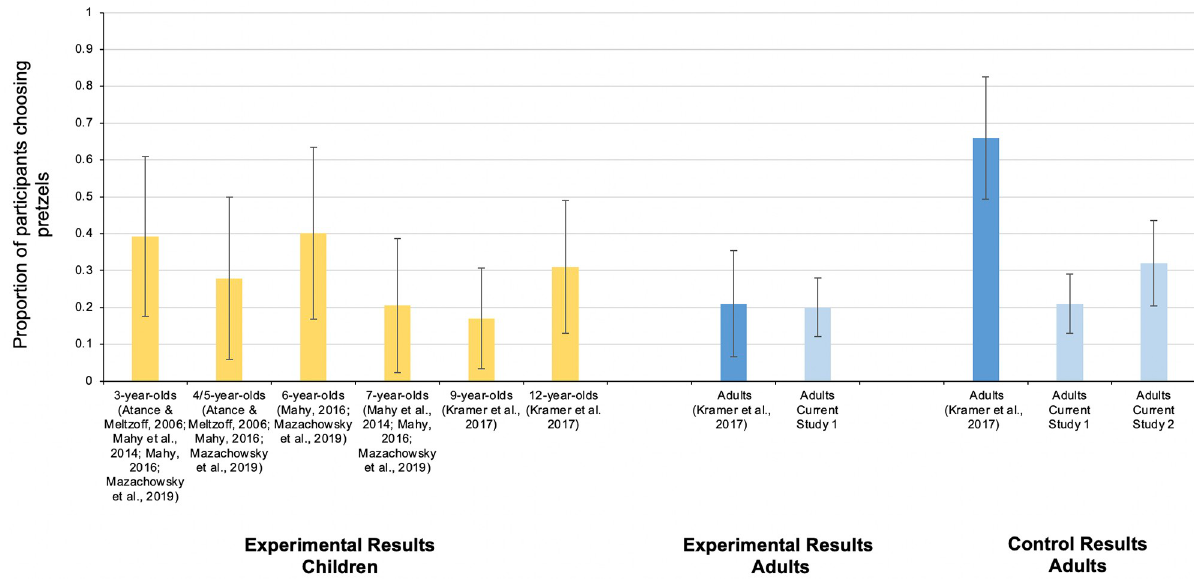
Fig 2. Pretzel task performance across age using previously collected data and the current study. Error bars represent 95% confidence intervals using weighted means.